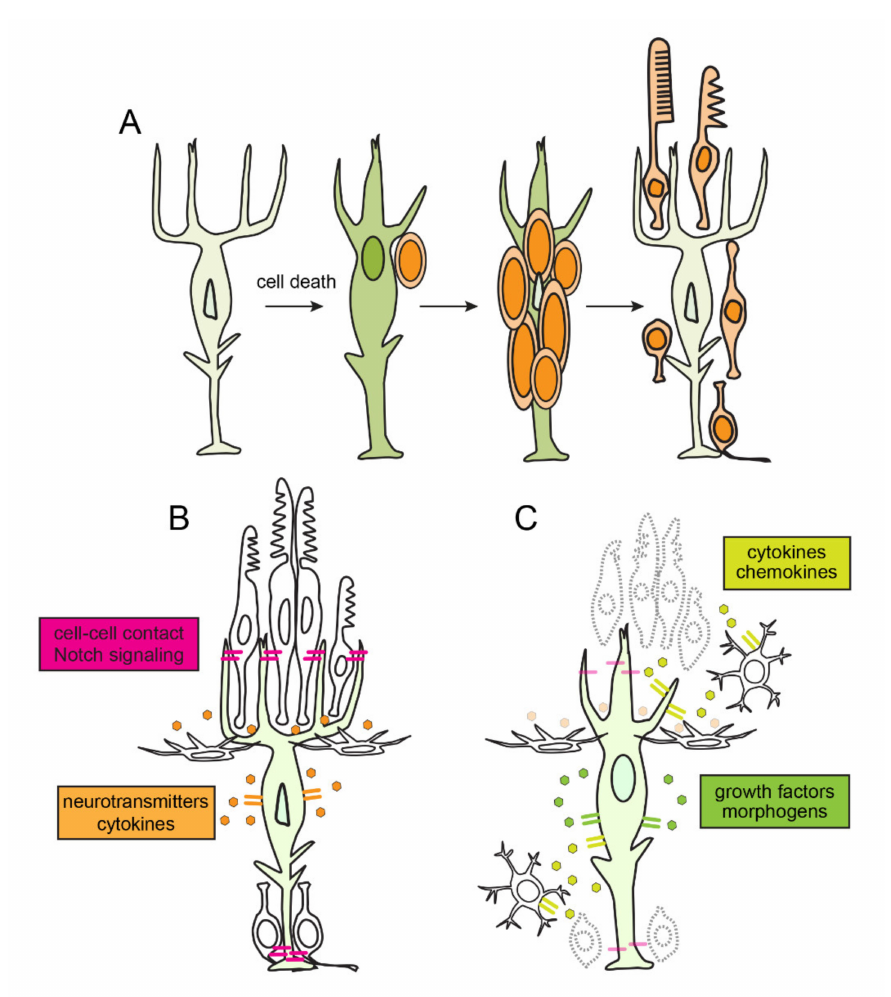
Figure 1. Retinal regeneration, regulation of quiescence and reprogramming of Müller glia in zebrafish. ( A ) Time course of retinal regeneration. Following cell death, Müller glia dedifferentiate and reprogram into a stem cell-like state. Müller glia then undergo interkinetic nuclear migration an asymmetric self-renewing division, which produces a multipotent retinal progenitor. Müller glia-derived progenitors then proliferate rapidly, migrate and differentiate into the ablated retinal neurons. ( B ) In an unlesioned retina, cell-cell contact mediated signaling, neurotransmitter dynamics, and autocrine signaling mechanisms maintain Müller glia in a quiescent state. ( C ) In response to cell death, soluble factors, cytokines, and chemokines, secreted from dying neurons and activated microglia induce reprograming of Müller glia. Müller glia themselves secrete growth factors